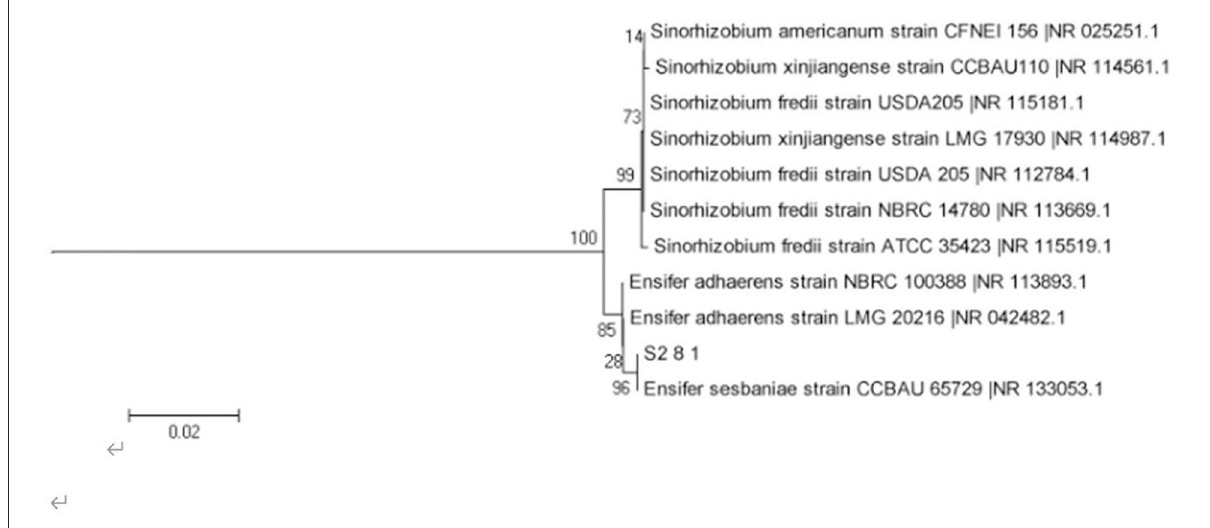
FIGURE2 Phylogenetic tree based on the 16S rDNA sequence of 1 AOB strain. The S2_8_1 in the figure is the strain that has been isolated and screened in the present study.